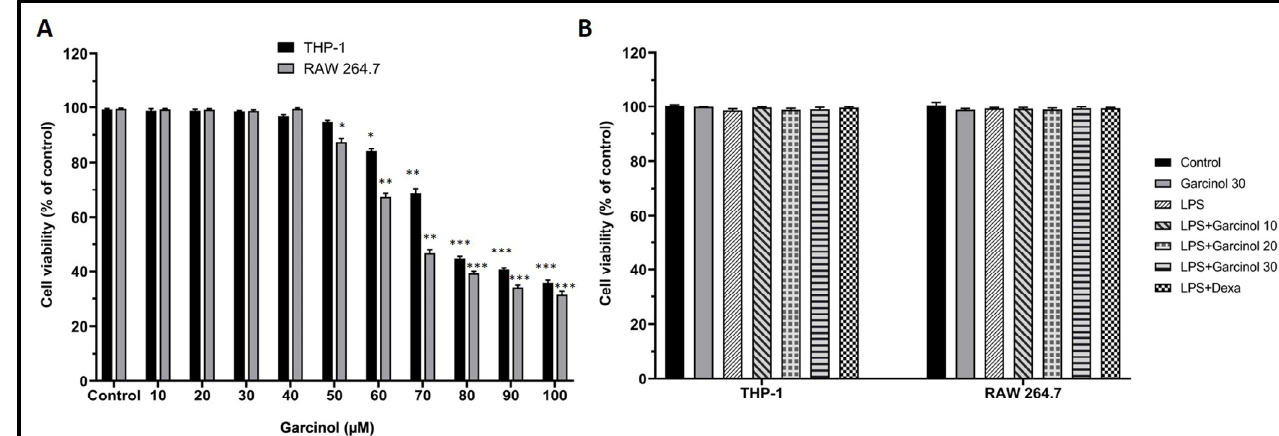
Figure 2. The effect of various concentrations of garcinol on the cell viability of THP-1 cells and RAW264.7 was determined ( A ). The cell viability of another experiment that performed the co-incubation of garcinol or 5 µM of dexamethasone (dexa) with LPS (500 ng/mL) was evaluated ( B ). The results of each group are presented as the relative expression to control. The data are presented as mean ± SD from six replicates examination in three independent experiments. For statistical analyses, One-way ANOVA followed by Dunne tt (cid:31)s test was used. * p < 0.05, ** p < 0.01, *** p < 0.001.